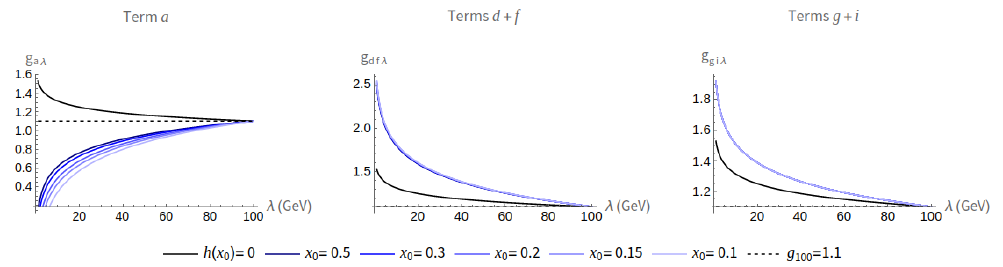
Figure 4. Relevant contributions from terms a , d + f and g + i to the running coupling (terms linear in the di ff erence ¯ t − ¯ t 0 and logarithms (cid:4) (cid:5) √ ¯ t ¯ t 0 ¯ ξ 4 log e γ E are not taken into account because they cancel in the final expression). Self-energy terms contribute to asymptotic freedom, the triangle term does not, and dominates over the other two for low values of x 0